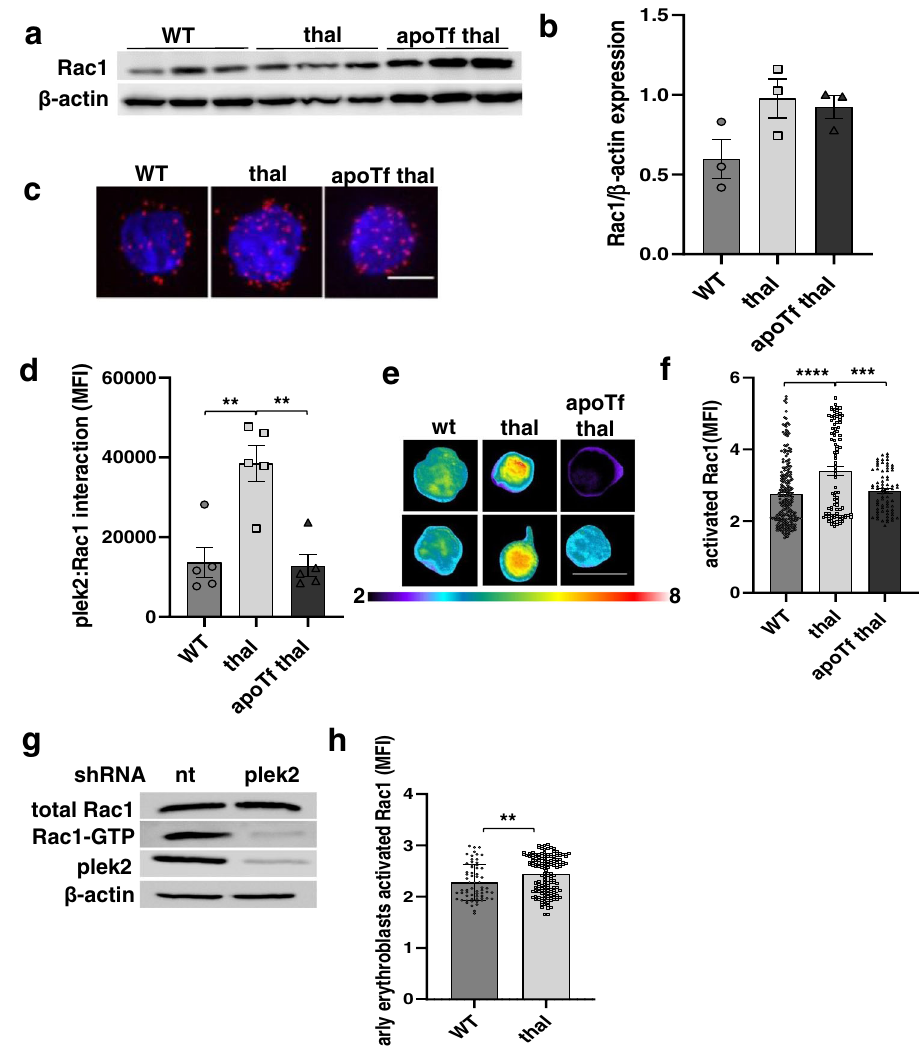
Fig. 6 Pleckstrin-2 interacts with and results in RacGTPase activation in erythroid precursors. a Western blot for Rac1 expression in bone marrow erythroblasts from WT, β -thalassemic, and apoTf-treated β -thalassemic mice. b Statistical analysis of ( a ) reveals no difference in Rac1 expression between groups ( n = 3 mice/group; MW = Rac1 21 kDa, actin 42 kDa). c Confocal immuno fl uorescence microscopy of Rac1 and plek2 interaction (red) using the proximity ligation assay in sorted bone marrow Pro-Es from (2 – 3 mice pooled per data point, n = 3 data points per category) WT, β -thalassemic, and apoTf-treated β -thalassemic mice. Scale bar 5 µ m. d Statistical analysis of ( c ) quantifying Rac1 and plek2 interaction, demonstrating increased interaction in Pro-E from β -thalassemic relative to WT mice, normalized after apoTf treatment. e FRET of activated Rac1 in erythroblasts from WT, β -thalassemic, and apoTf-treated β -thalassemic mice. Scale bar 10 µ m. The images are representative cells from at least 20 cells analyzed in each condition. f Statistical analysis of ( e ) reveals more activated Rac1 in β -thalassemic relative to WT erythroblasts, normalized after apoTf treatment. All data are reported as mean ± s.e.m. and p < 0.05 is considered statistically signi fi cant (one-way ANOVA). g Activated Rac1 pull-down from fetal liver cells from E13.5 WT embryos transfected with nt-shRNA and plek2-shRNA (MW = plek2 38 kDa, Rac1 21 kDa, actin 42 kDa). h Statistical analysis of activated Rac1 FRET in WT and β - thalassemic erythroblasts ( n = 4 mice/group) cultured for 24 h (early erythroblasts) reveals more activated Rac1 in β -thalassemic relative to WT. All data are reported as mean ± s.e.m. and p < 0.05 is considered statistically signi fi cant (Student ’ s unpaired t -test). All data are reported as mean ± s.e.m. and p < 0.05 was considered statistically signi fi cant (two-way ANOVA) (* p ≤ 0.05, ** p ≤ 0.005, *** p ≤ 0.0005). WT = wild type; thal = β -thalassemic; apoTf